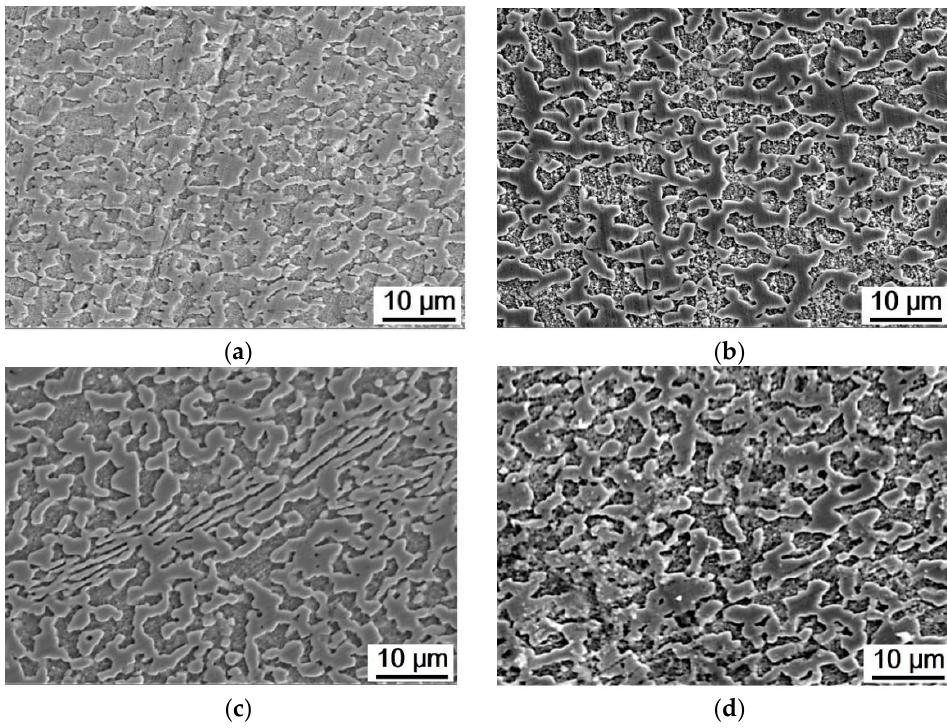
Figure 5. Microstructures of the Bi – Sn samples after t-HPS processing for five turns and storage at RT for ( a ) 8 h, ( b ) 2 days, ( c ) 7 days and ( d ) 21 days.